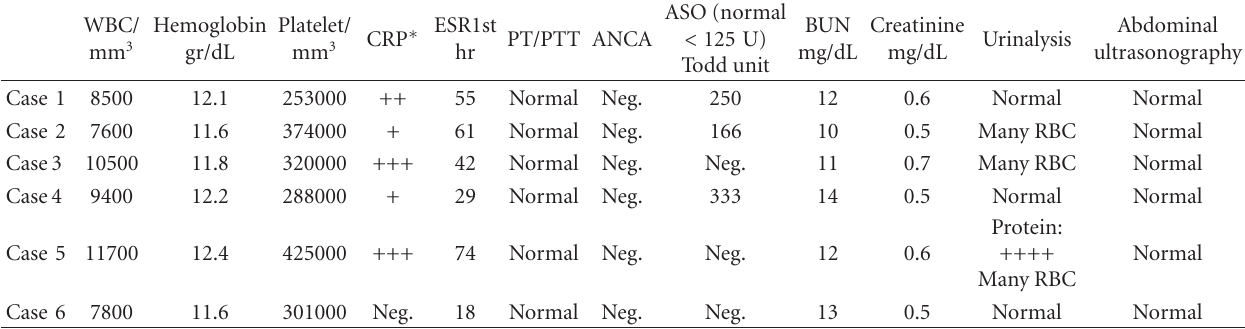
Table 2: Laboratory data and ultrasonographic findings of patients. ∗ Only qualitative measurement of CRP was available at our center.